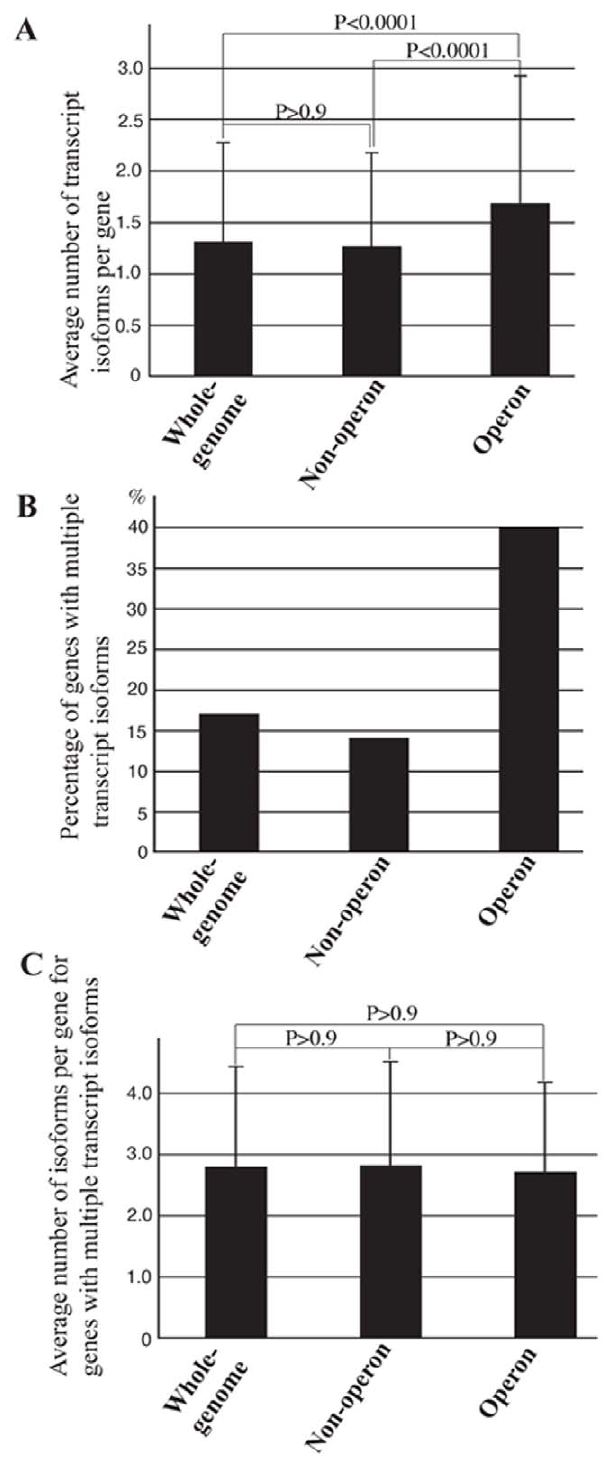
Figure 1. C.elegans operons contain a higher proportion of genes that express multiple transcript isoforms. (A) C. elegans operonic genes express more transcript isoforms per gene than non-operonic genes do. (B) C. elegans operons contain a higher proportion of genes that express multiple transcript isoforms than non-operonic genes do. (C) Alternatively spliced C. elegans operonic genes and non-operonic genes have a similar number of transcript isoforms per gene. Z-test was performed (Figure 1A and 1C) to evaluate the significance of difference between the means of transcript numbers. Error bars represent standard deviations.